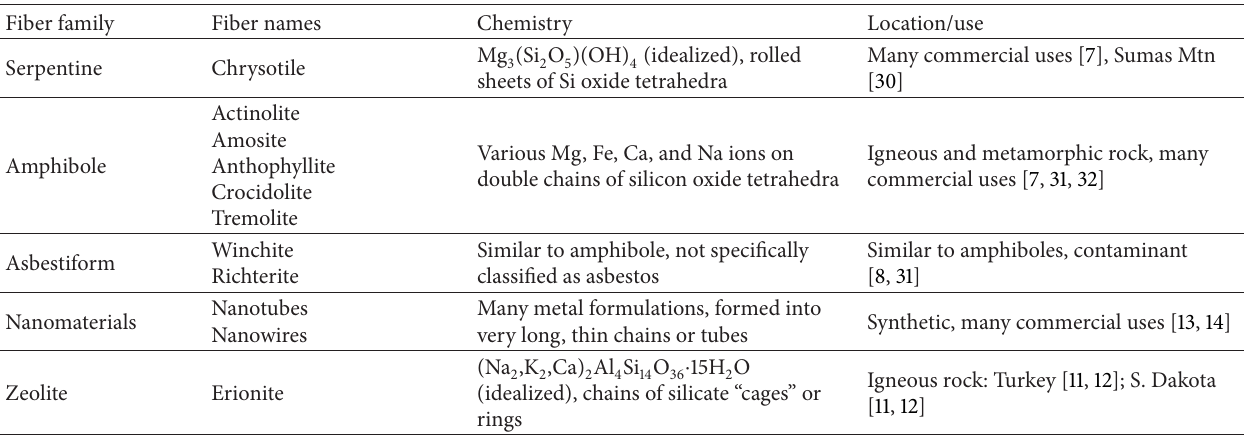
Table 1: Description of mineral fibers discussed.